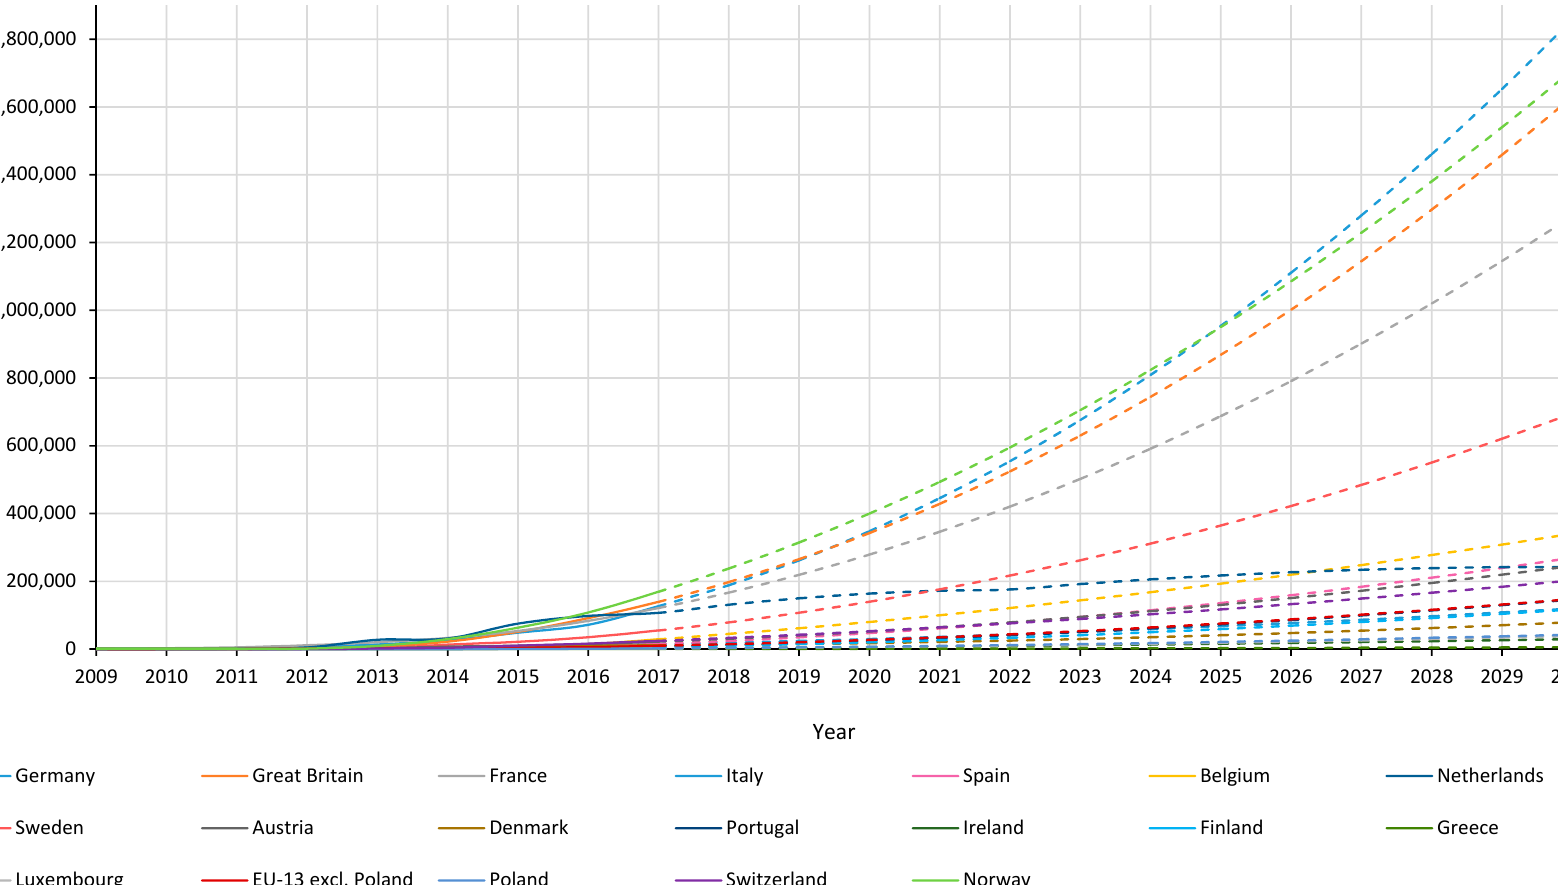
Figure 1. The cumulative number of new electric car registrations in the European Union, Norway and Switzerland in 2009–2017 with a forecast until 2030.